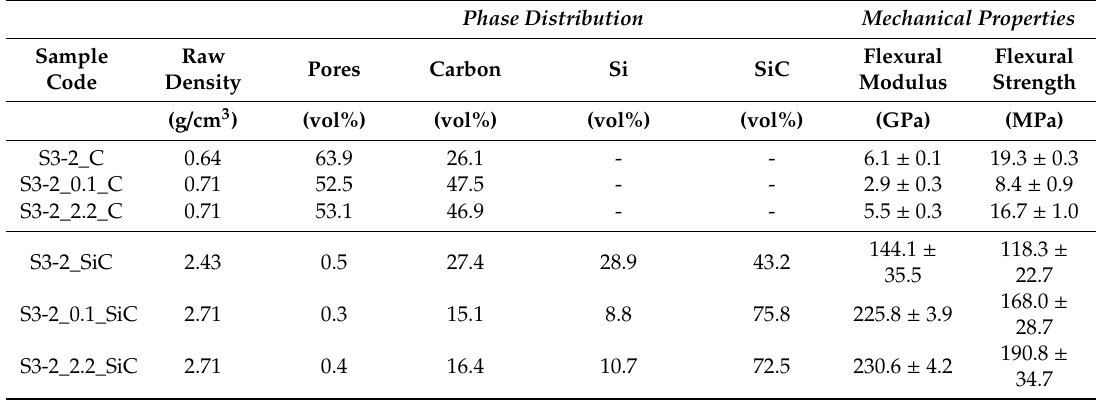
Table 7. Raw densities, phase distributions, and mechanical properties of the C and C / Si / SiC specimens.